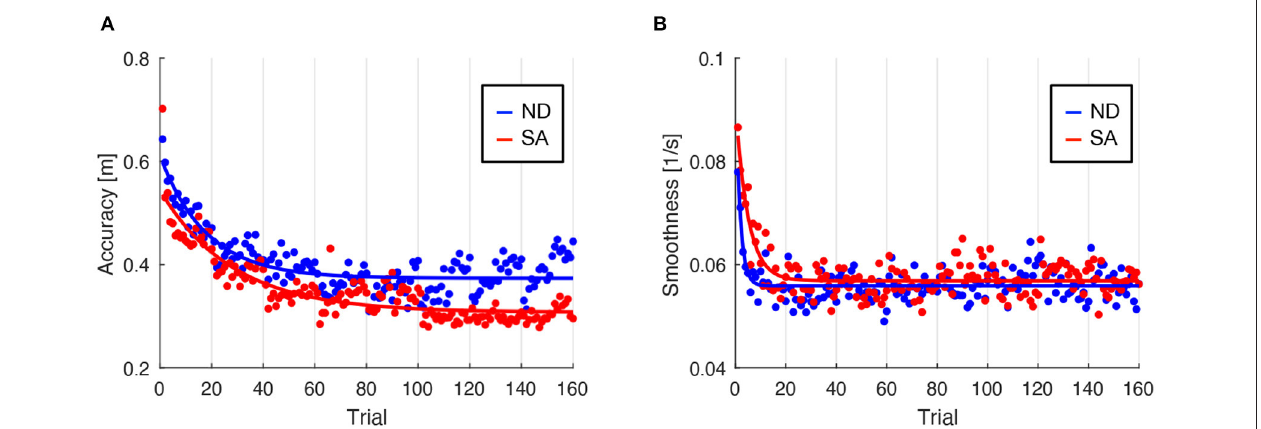
FIGURE 2 | Trajectories of driving performance during lane-keeping training. Driving performance was indexed with regard to the accuracy (A) and smoothness (B) of steering as a function of trial number. Blue and red dots represent mean performance in each trial, separately averaged across participants under ND and SA conditions. Each line denotes a learning curve fitted to determine learning rate and learning plateau. Vertical thin lines indicate respective training